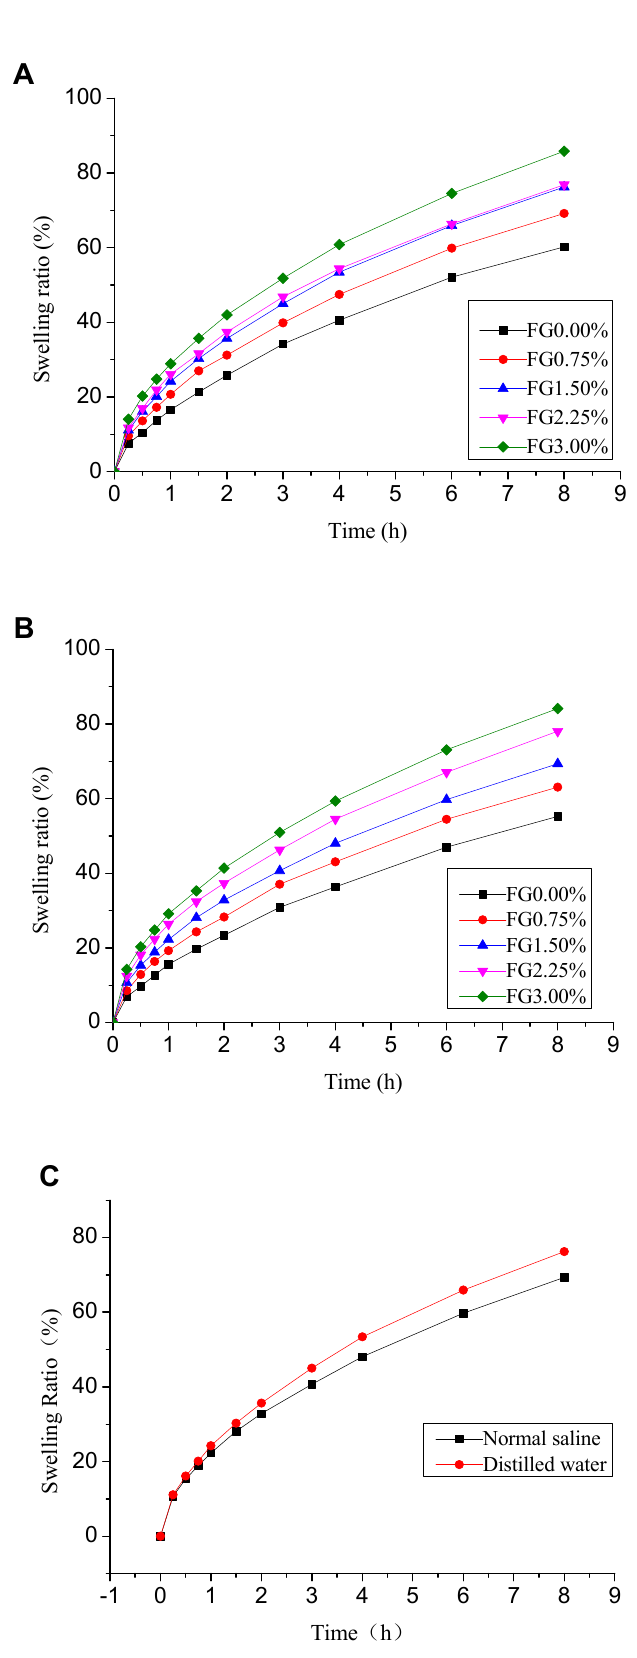
Figure 4. Swelling ratio of PVA / FG composite hydrogel (PVA content is 10%) in distilled water ( A ), in physiological saline ( B ) and a comparison of swelling degree of composite hydrogel (10% PVA + 1.5% FG) in distilled water and physiological saline ( C ).